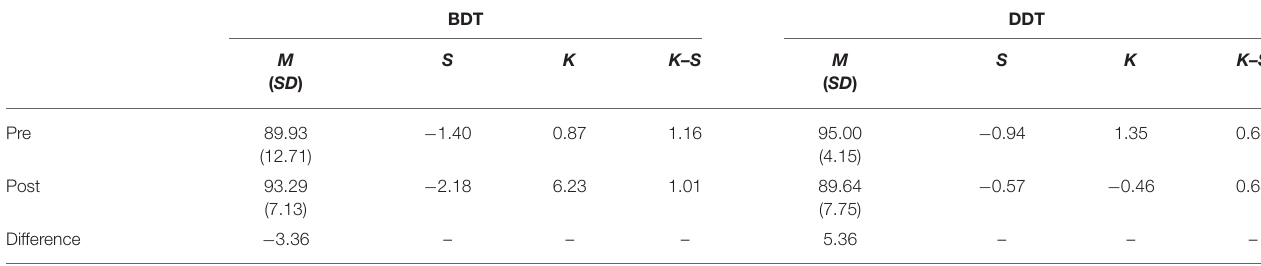
TABLE 7 | Accuracy (%) of BDT and DDT before and after the mindfulness training in elite archery athletes of the national team ( n = 14). BDT